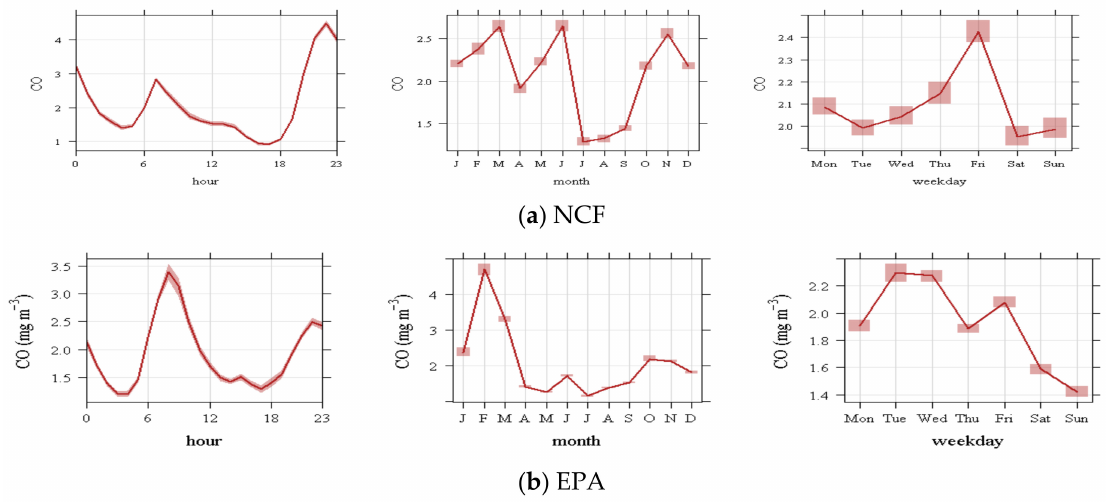
Figure 3. Example of CO variation for near Gulf-of-Guinea site (NCF) and inland site (EPA), including diel average in local time (left), monthly average (center), and weekday average (right). Graphs ( a ) are for NCF and ( b ) for EPA sites. The vertical bands show variability (pink) ± in values, e.g., 5–95% range. Graphs for the remaining sites are in the Supplementary Materials, Figures